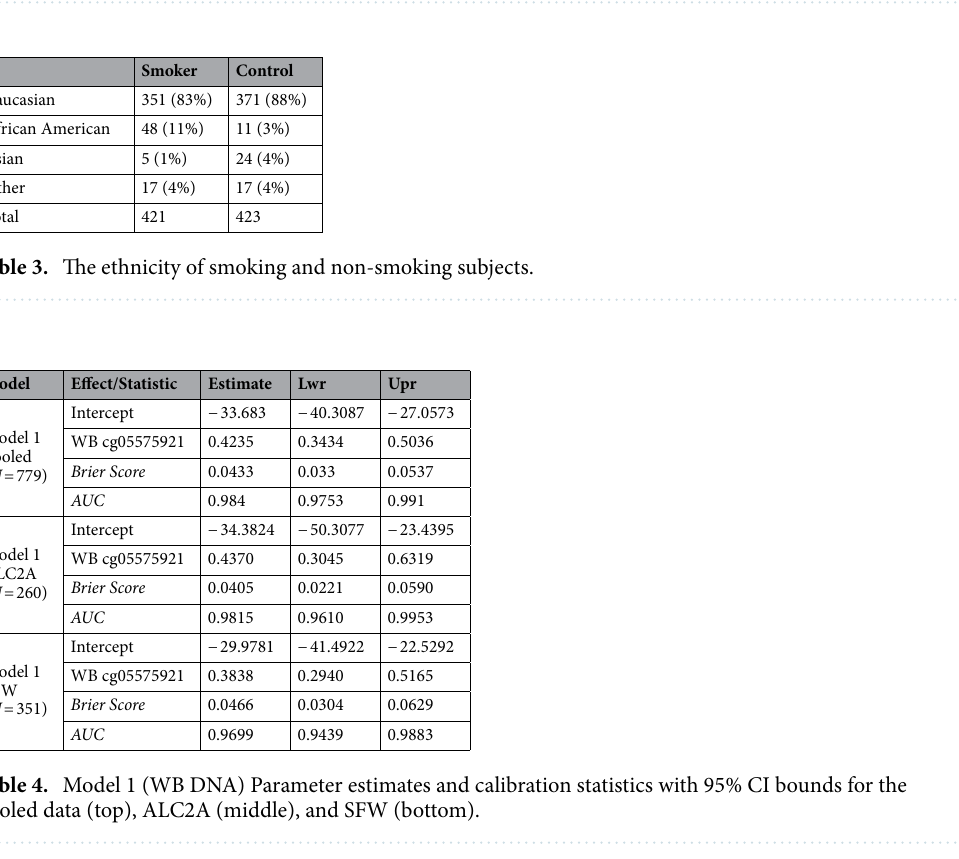
Table 2. Model 1 (WB DNA) Brier scores and Brier scores differences for the test and training data sets. * Bolded numerical entries are the Brier scores for which the training and test data are identical. **95% CI intervals for Brier Scores and differences are given in parentheses.